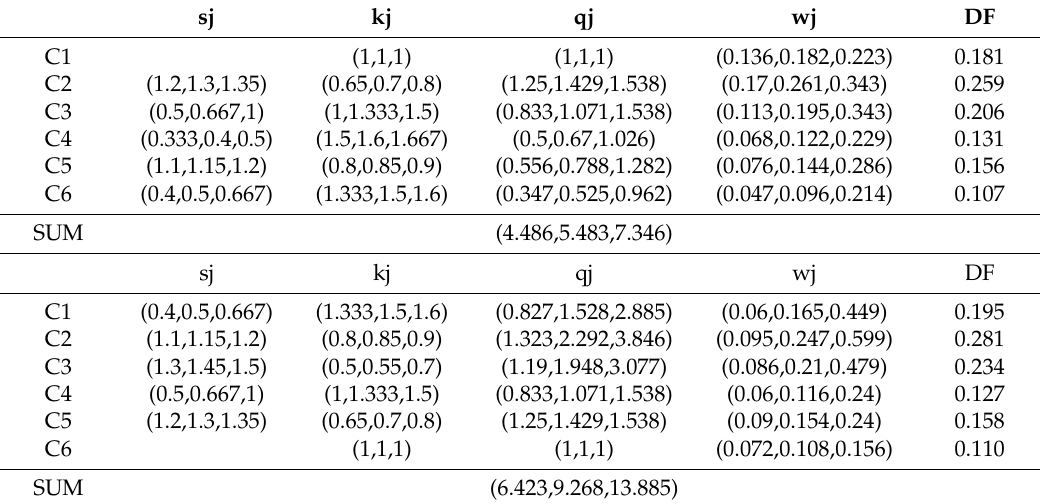
Table 3. Calculation and results of applying the fuzzy PIPRECIA method for determining the criterion